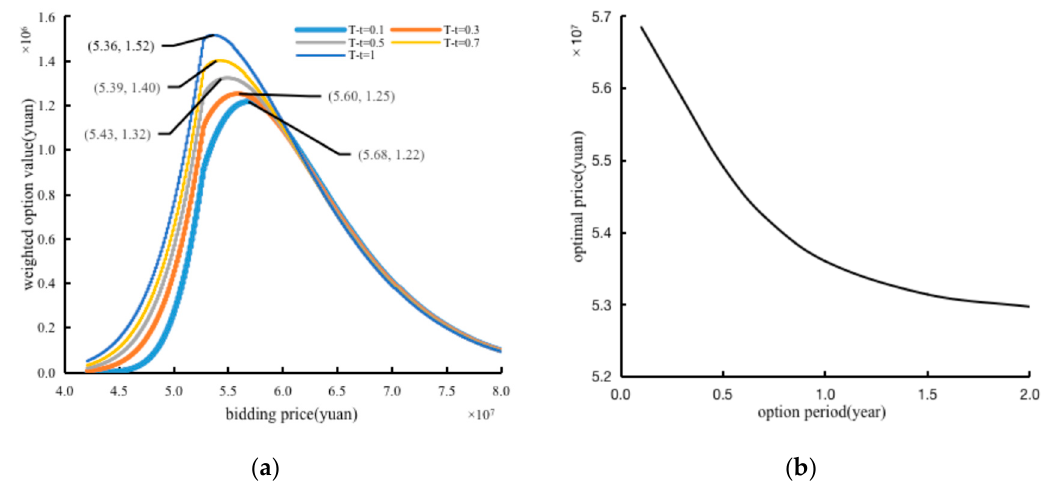
Figure 5. Sensitivity analysis of the option period. ( a ) Period sensitivity; ( b ) Fluctuation trend of optimal price. ( C t = 50,000,000; b = 10; n = 1.1; u = 0.3; r = 0.01; σ = 0.2 ; N = 50; AP comps = 52.79 million).